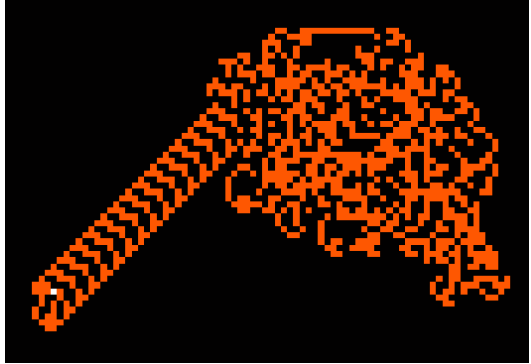
Figure 5. The ant (white cell), after 11,538 iterations, is stuck in “The